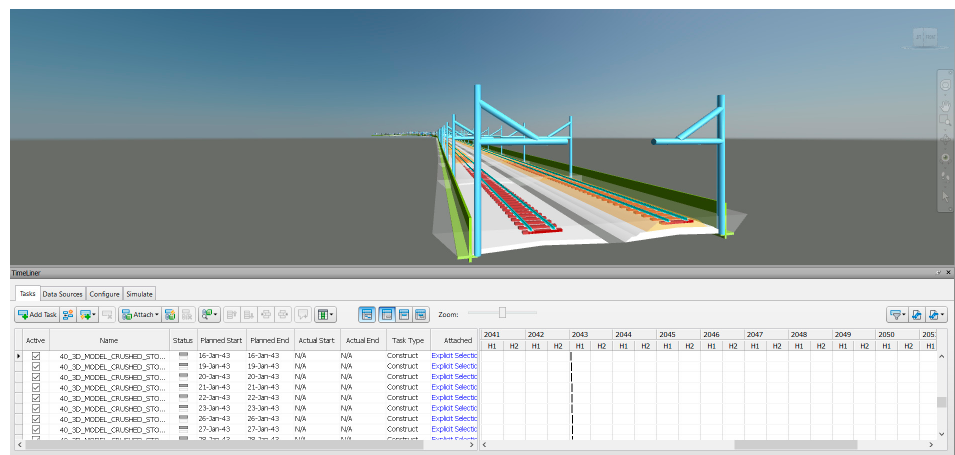
Figure 13. A 3D BIM model.